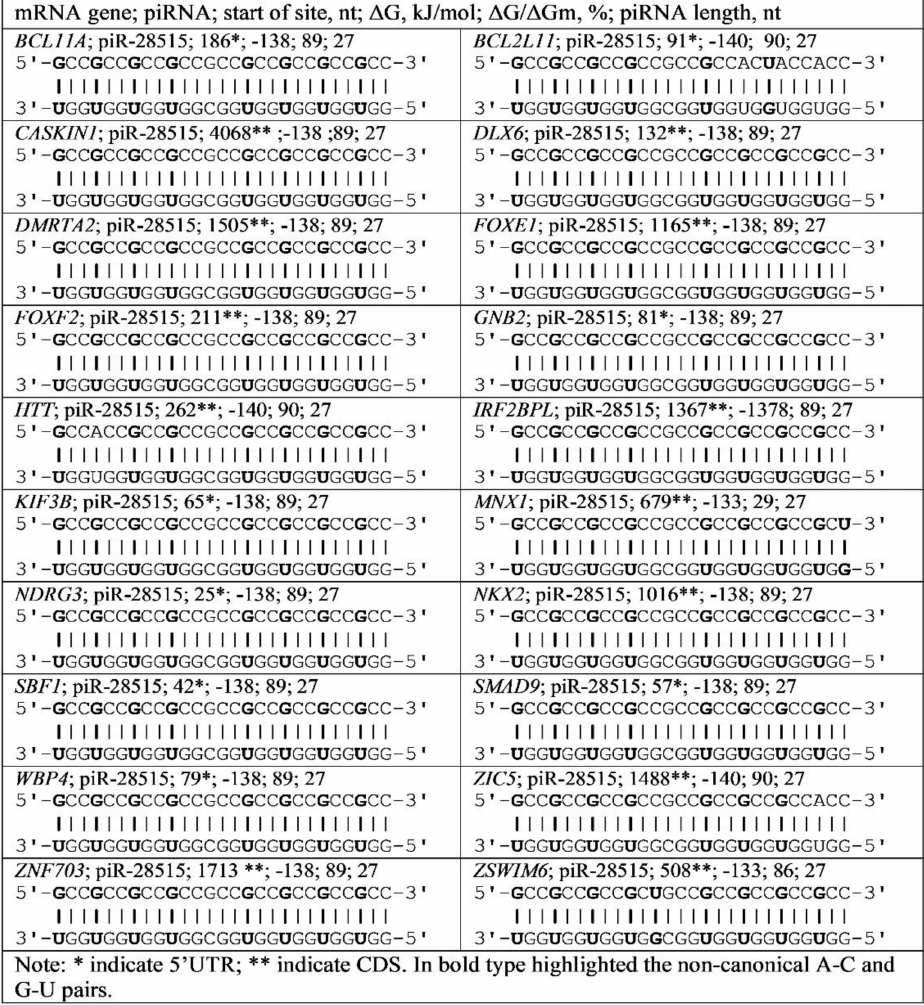
Figure 6. Schemes of piR-28515 interaction with mRNA regions of various genes containing GCC